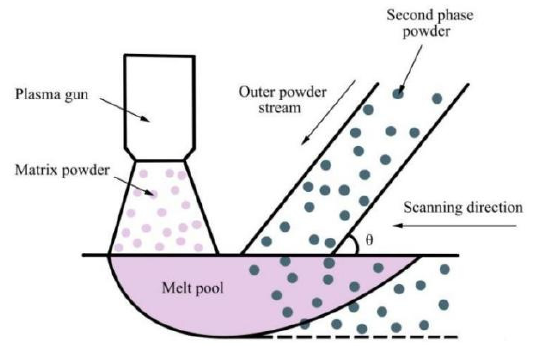
Figure 2. Schematic illustration of the PTA + PMI method.